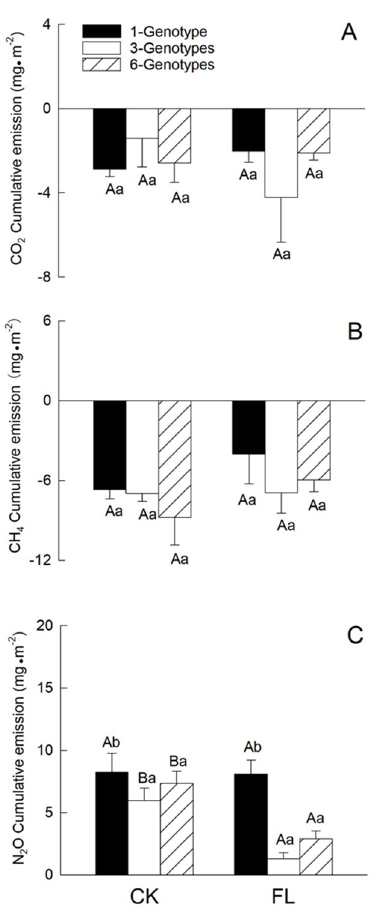
Figure 6. Effects of genotypic diversity and flood on the accumulated emission flux of greenhouse gases ( A ) CO 2 , ( B ) CH 4 and ( C ) N 2 O from the wetland microecosystem (mean ± SE). The control and flooding treatments were named as CK and FL, respectively. Different capital letters indicate significant differences among genotypic diversity treatments, and lower-case letters indicate significant differences among flooding treatments ( p < 0.05).